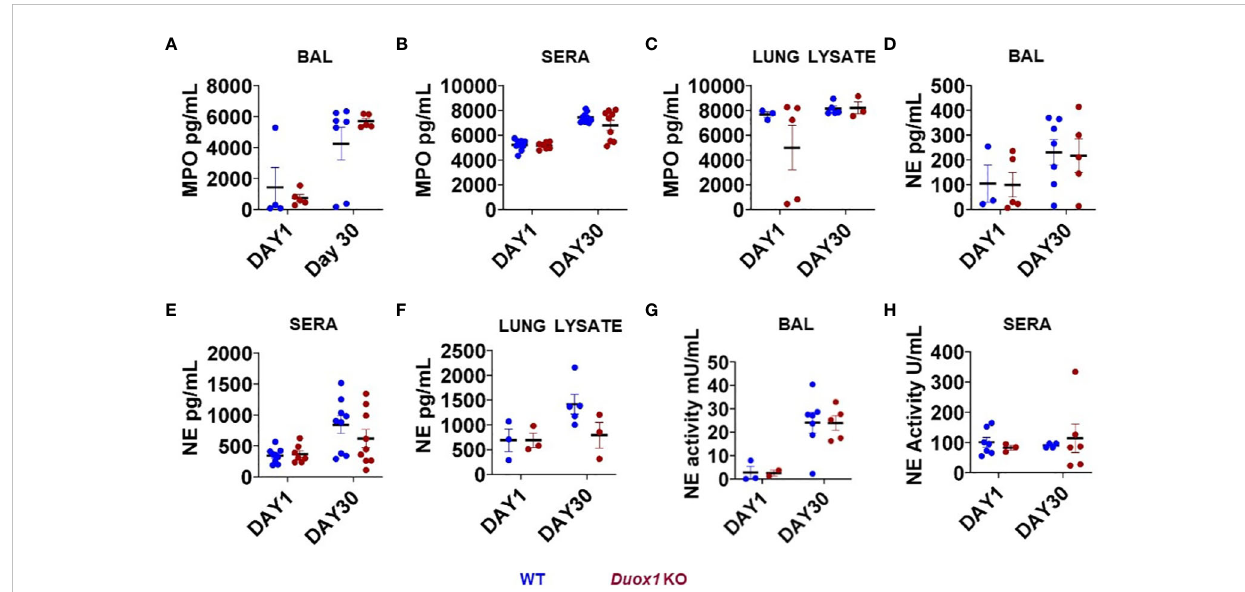
FIGURE 5 Neutrophil markers in the blood and airways of Mtb -infected Duox1 KO mice. The concentrations of MPO and NE were measured in the BAL fl uid, sera and lung lysates from Mtb -infected WT and Duox1 KO mice at 1 and 30 days post-infection. NE enzymatic activities in cell-free BAL fl uid and sera are also shown. The following parameters were measured at 1 and 30 day(s) post-infection. (A) BAL MPO, (B) serum MPO, (C) MPO in lung lysates, (D) BAL NE, (E) serum NE, (F) NE in lung lysates, (G) NE activity in BAL and (H) NE activity in sera. Statistical comparisons were done with ANOVA followed by multiple comparisons. No signi fi cant differences were found. The concentrations of both MPO and NE are expressed in pg/ml. BAL, bronchoalveolar lavage fl uid; Duox1 KO, Duox1 -de fi cient; MPO, myeloperoxidase; NE, neutrophil elastase; WT,